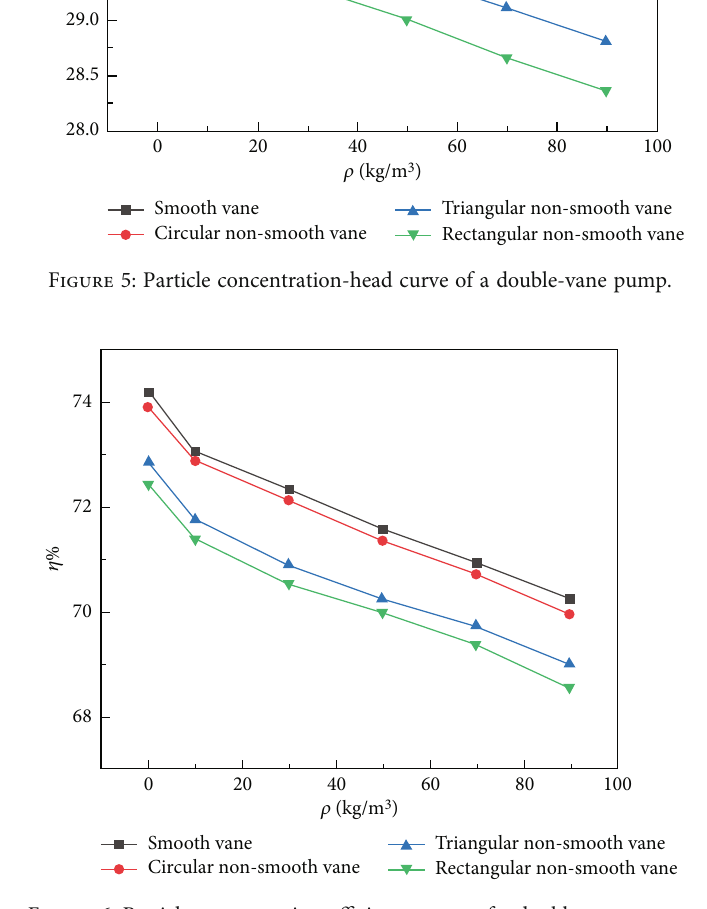
Figure 6: Particle concentration-e ffi ciency curve of a double-vane